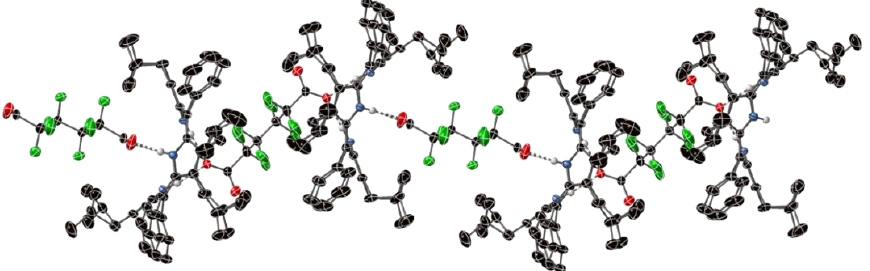
Figure 5. Two repeat units of the one-dimensional hydrogen-bonded chain of [H 4 OiBuTPP] 2+ with [C 6 F 8 O 4 ] 2 − from the crystal structure of compound [H 4 2 ](O 2 C(CF 2 ) 4 CO 2 )·1.5(CH 2 Cl 2 )·1.5(CH 3 OH) (compound 2 ).